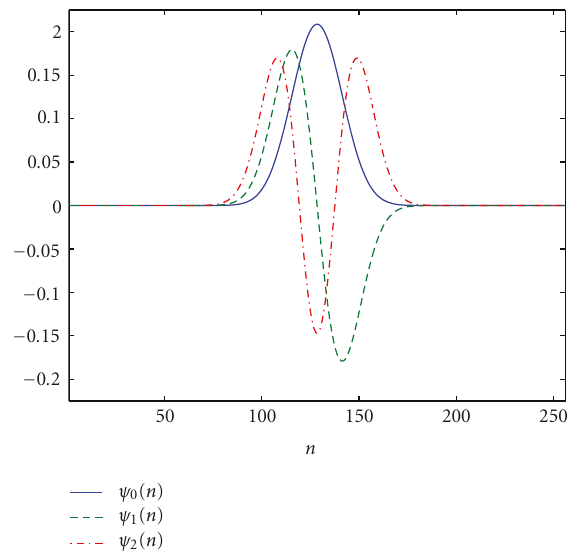
Figure 1: Baseband DPSS for N = 256, W = 1 / 8, and K = 64 (note that K = (cid:5) 2 NW (cid:6)